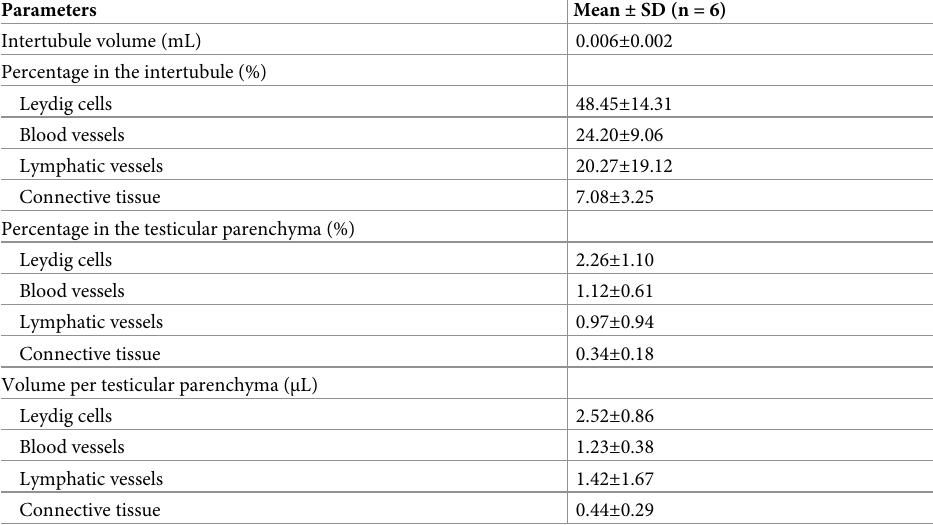
Table 2. Volumetric proportion (%) and volume of the intertubular compartment of Diphylla ecaudata . The data are reported as mean ± standard deviation (SD) of the